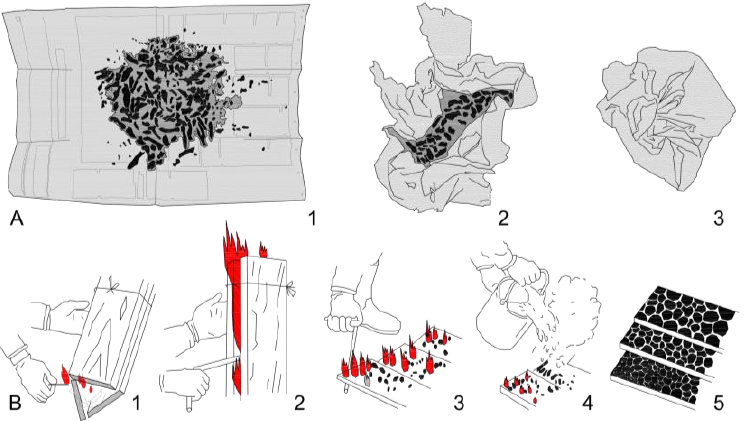
Figure 1. Guideline to handcraft an ignitor ball ( A ) and methodology of surface charring in the traditional Japanese method ( B ).